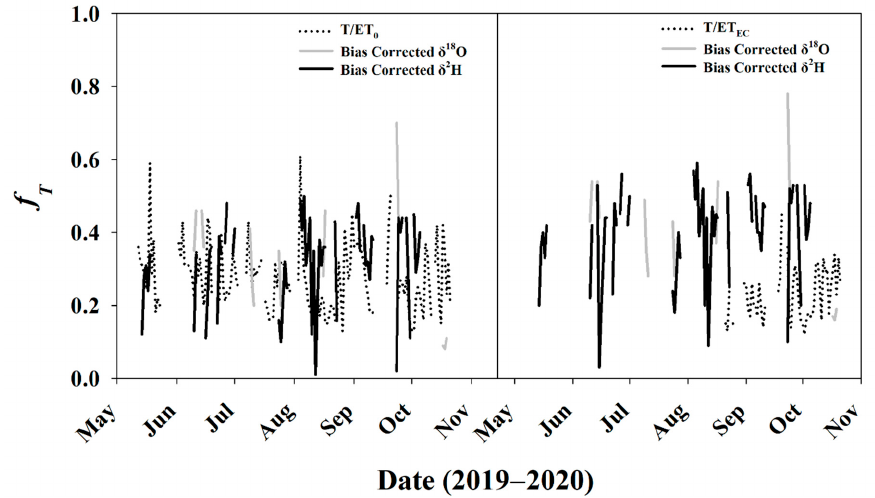
Figure 11. Stable isotope f T bias-corrected to ( left ) ET 0 ; ( right ) ET EC . Data for ET EC before DOY 241 were invalid and excluded from the analysis. were invalid and excluded from the